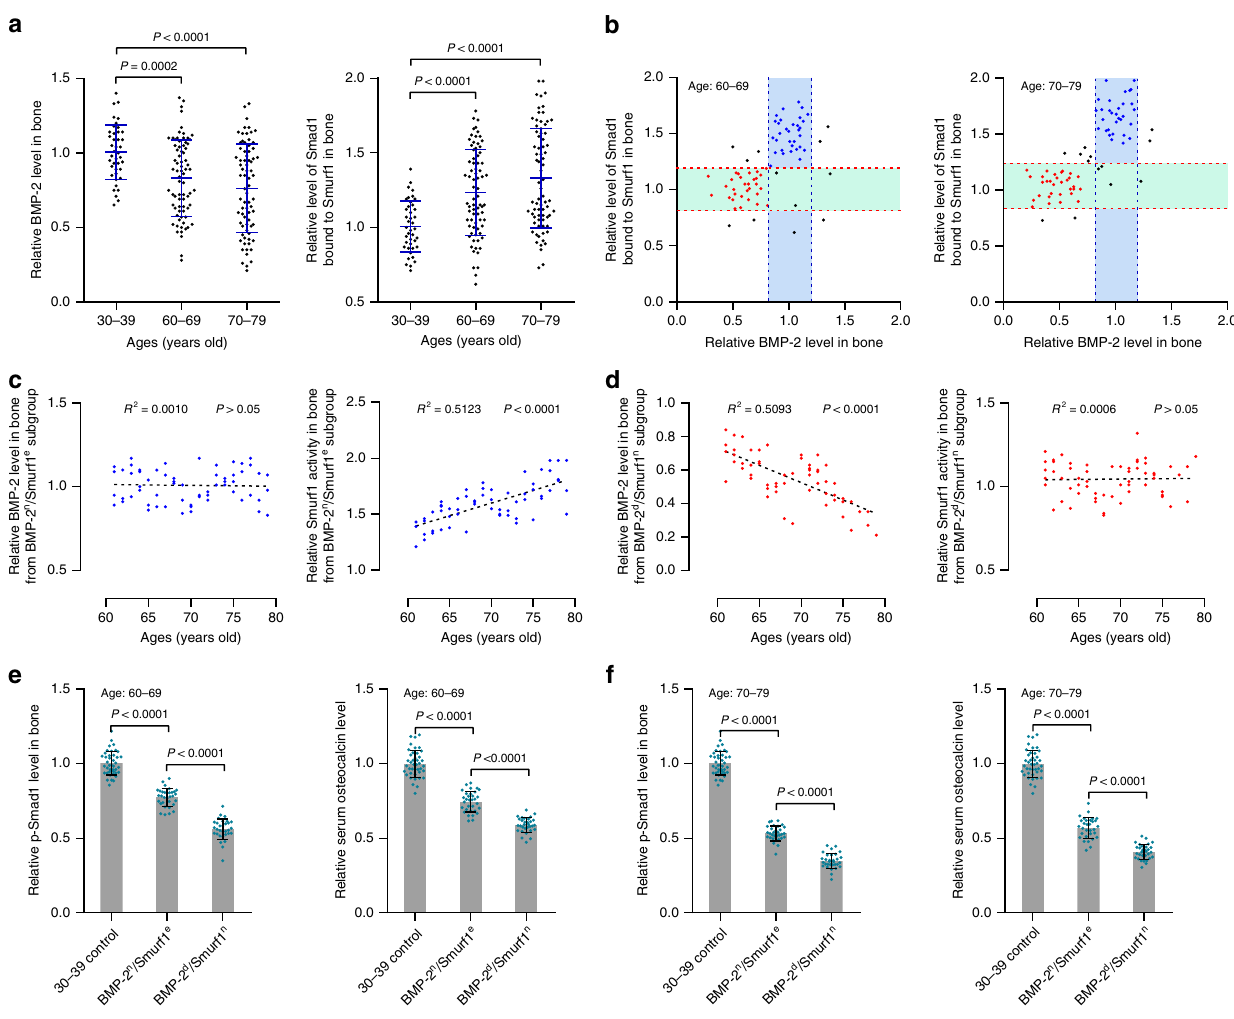
Fig. 1 BMP signaling, Smurf1 activity and subgroup classi fi cation of aged osteoporotic patients. a Relative levels of intraosseous BMP-2 (left) and Smurf1 activity (Smad1 bound to Smurf1, right) in osteoporotic VCF patients aged 60 – 69 ( n = 75) or 70 – 79 years old ( n = 75). b Classi fi cation of aged patients into subgroups based on intraosseous BMP-2 levels and Smurf1 activity (Smad1 bound to Smurf1) (left, 60 – 69 years old; right, 70 – 79 years old). The cluster of blue dots, BMP-2 n /Smurf1 e subgroup; the cluster of red dots, BMP-2 d /Smurf1 n subgroup. Relative levels of intraosseous BMP-2 (mean ± s.d., indicated by the two blue dashed lines) and Smad1 bound to Smurf1 (mean ± s.d., indicated by the two red dashed lines) in adult traumatic VCF patients (30 – 39 years old) served as cutoff parameters. c Relative levels of intraosseous BMP-2 (left) and Smad1 bound to Smurf1 (right) in BMP-2 n /Smurf1 e subgroup ( n = 63). d Relative levels of intraosseous BMP-2 (left) and Smad1 bound to Smurf1 (right) in BMP-2 d /Smurf1 n subgroup ( n = 62). e Relative levels of intraosseous p-Smad1 (left) and serum osteocalcin (right) in BMP-2 n /Smurf1 e subgroup ( n = 32) and BMP-2 d /Smurf1 n subgroup ( n = 31) of patients (60 – 69 years old). f Relative levels of intraosseous p-Smad1 (left) and serum osteocalcin (right) in BMP-2 n /Smurf1 e subgroup ( n = 31) and BMP- 2 d /Smurf1 n subgroup ( n = 31) of patients (70 – 79 years old). The levels of BMP-2, p-Smad1, osteocalcin and Smad1 bound to Smurf1 in each osteoporotic VCF patients from 60 – 69 or 70 – 79 age group were normalized to the mean values of adult traumatic VCF patients (30 – 39 years old) ( n = 41). Data are mean ± s.d. followed by one-way ANOVA with a post-hoc test